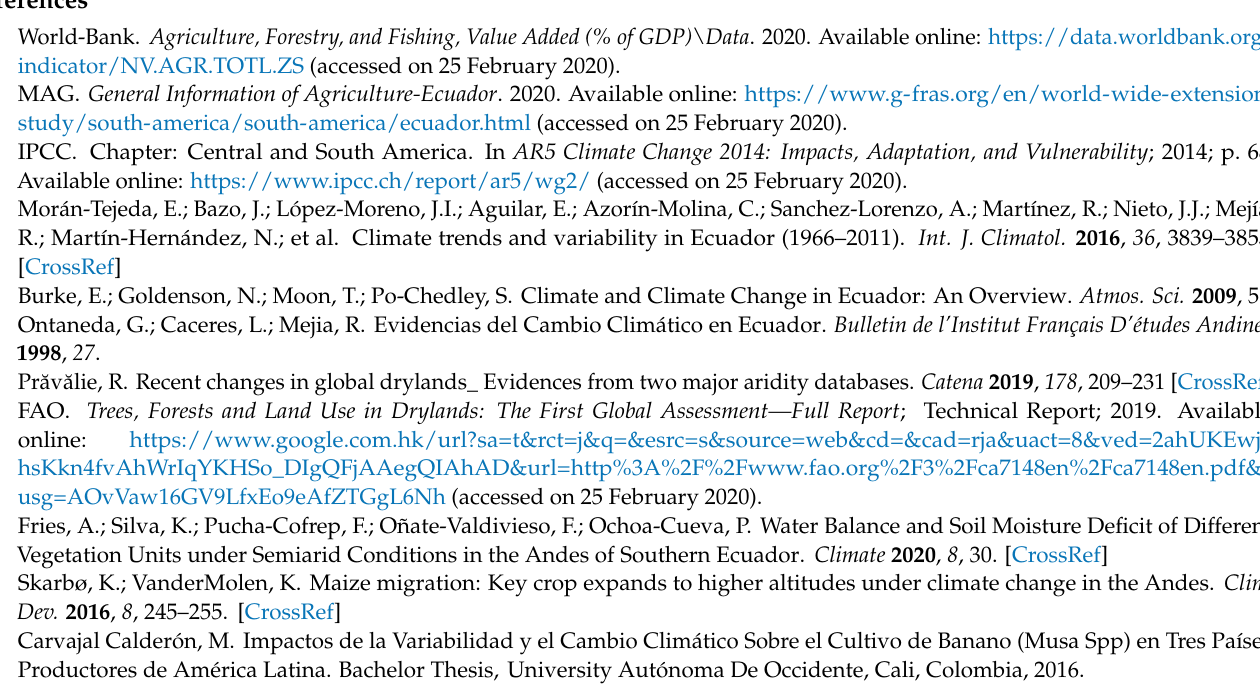
Figure A16. Time series of average radiation (MJ m − 2 ) in Manabi. ( a ) Heat-map of radiation (MJ m − 2 ) per each month and year from 1984 to 2019. The color scale represents the radiation (MJ m − 2 ). ( b ) Radiation averaged during the full year from 1984 to 2007. ( c ) Radiation averaged during the maize crop growing period in Ecuador (January–May) from 1984 to 2007. Each dot represents one record, the blue line shows the smoothed time series and the shaded area represents the 95% confidence